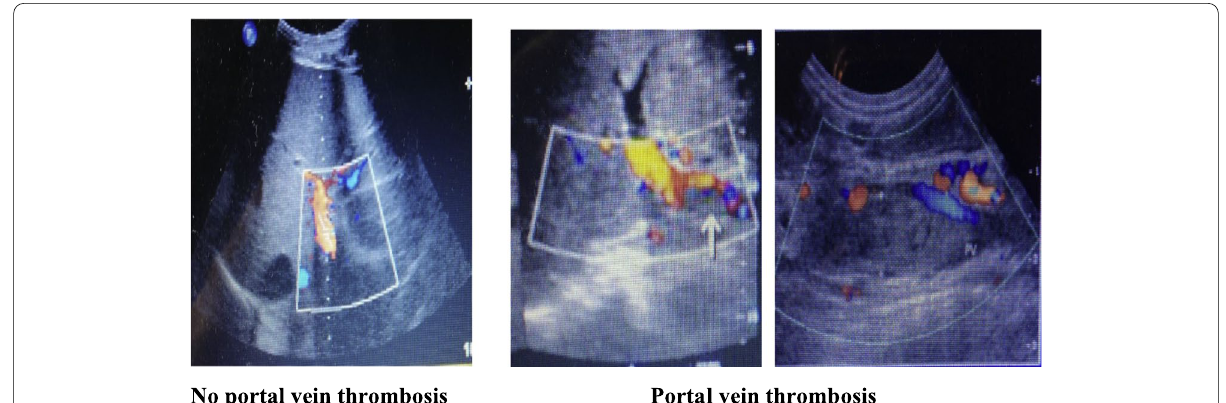
Fig. 1 Normal portal vein (no portal vein thrombosis) and portal vein thrombosis are represented by Doppler US images